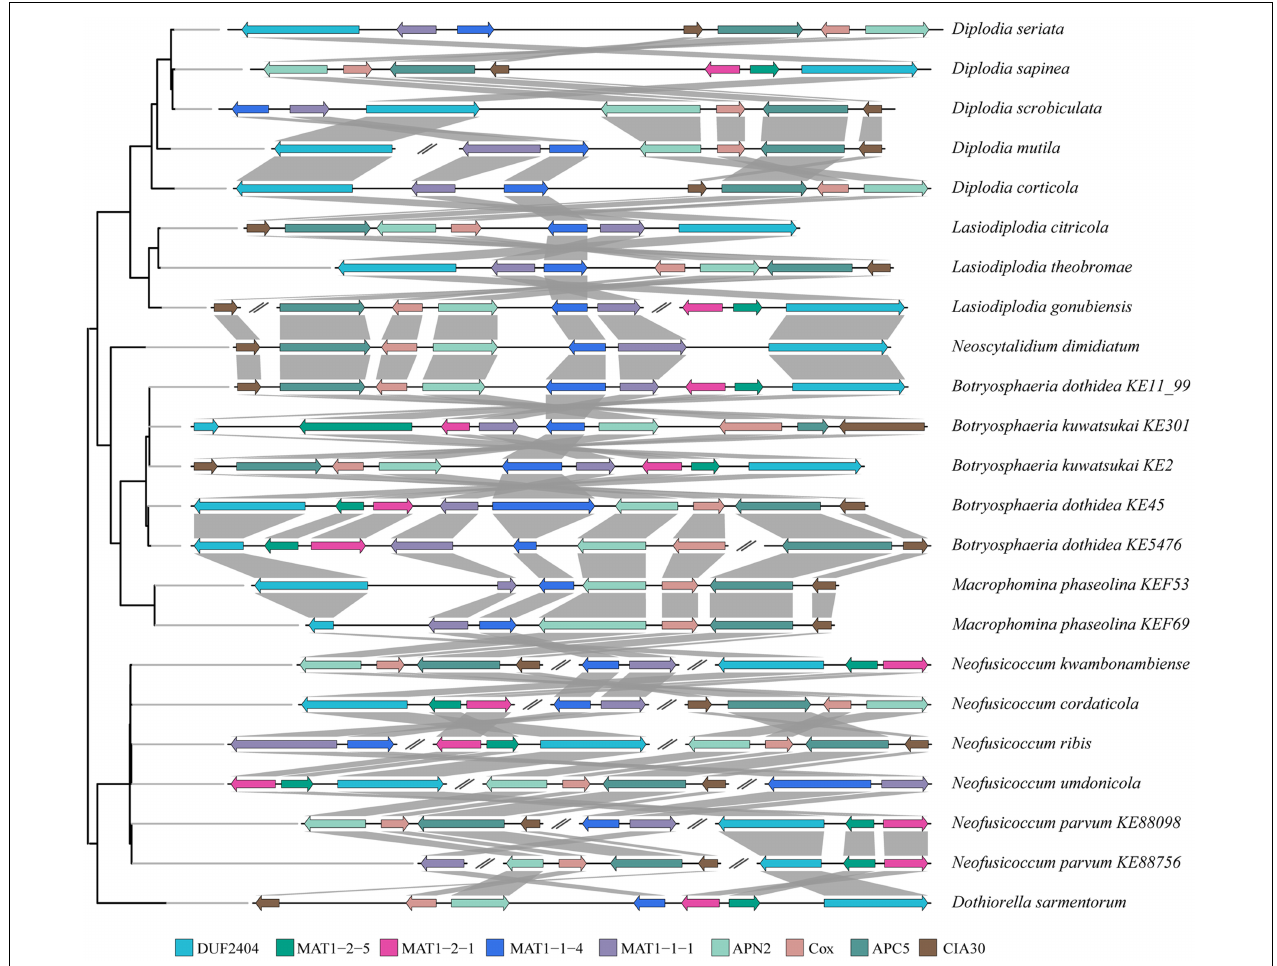
FIGURE 3 | Pairwise mating type and surrounding genes comparison between species of Botryosphaeriaceae . Genes (color coded arrows) were on genomic sequences (horizontal lines). Organization of genes were indicated by gray box. Abbreviations of genes: putative integral membrane protein containing DUF2404 domain (DUF2404), DNA lyase (APN2), cytochrome C oxidase subunit Via (Cox), anaphase-promoting complex subunit 5 (APC5) and Complex I intermediate-associated protein 30